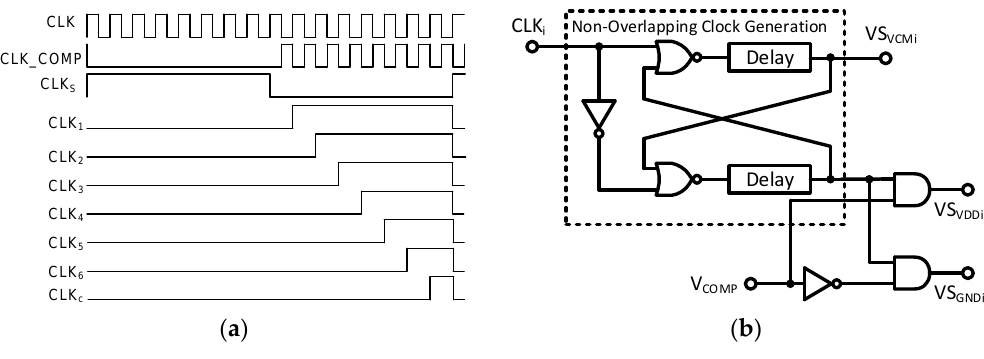
Figure 6. The comparator used in the SAR ADC.